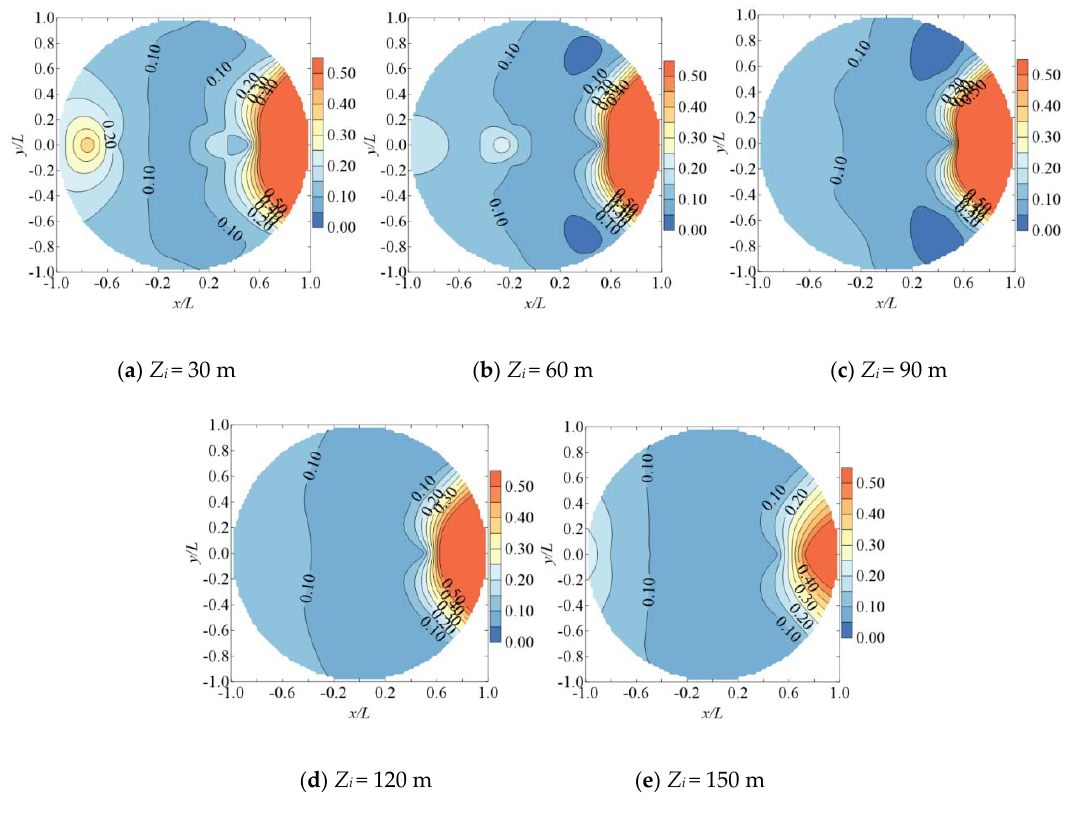
Figure 9. The streamwise turbulence intensity at different heights.